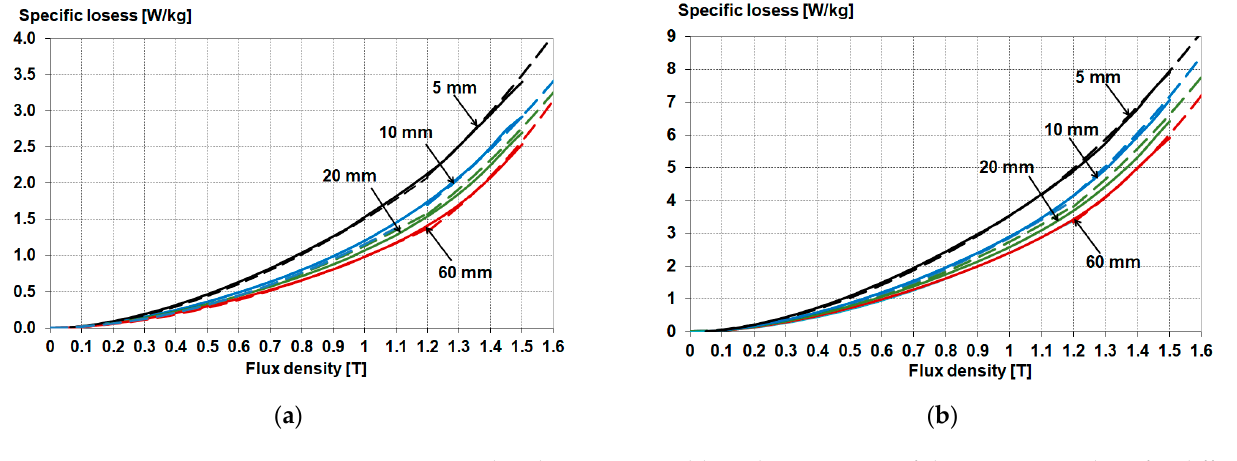
Figure 15. Measured and approximated loss characteristics of the M 270-35A sheet for different widths of the sheet samples, at the frequency of 50 Hz ( a ), and 100 Hz ( b ); (measured—solid line, estimated—dashed line).